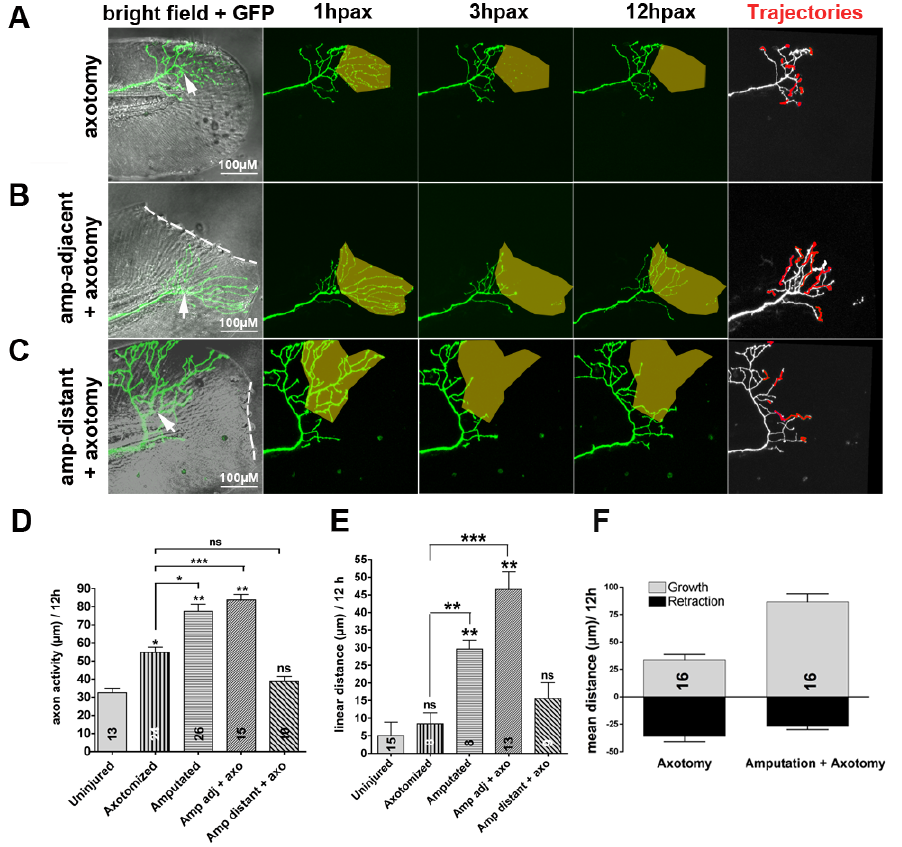
Figure 3. Signals from injured fins promoting axon regeneration function at short range. (A–C) Time-lapse sequences from 78–90 hpf. The rightmost panel shows axon tip trajectories (red) over the course of the time-lapse. (A) Axotomy (arrow) without amputation (see also Video S2). Axotomy increased axon activity, but axons were unable to reinnervate denervated territory (shaded area) (Figure S2). (B) The ability of an axotomized arbor (arrow) to reinnervate denervated territory (shaded area) was improved by fin amputation (dotted line) (see also Figure S2 and Video S4). (C) Axotomized arbors distant from the amputation plane did not regenerate (see also Video S5). (D, E) Comparison of axon activity (growth and retraction) (D) and linear growth distance (E) in uninjured arbors, after axotomy alone, after amputation alone, or after axotomy and amputation, both in close proximity (adj) or at a distance of greater than 50 m m. (F) Comparison of growth and retraction between axotomized axons, and axotomized axons in larvae whose fins were also amputated. Amputation in addition to axotomy promoted a shift from balanced growth and retraction toward growth. Sample size for each group is indicated by the number in the bar. Error bars represent the standard error of the mean. For statistical analyses, we performed one-way ANOVA and either Dunnett’s post-test to compare individual groups to uninjured controls (asterisks above bars indicate significance compared to control) or Bonferroni’s post-test to compare individual groups with each other (as indicated by brackets, p = ns . 0.05, * p , 0.05, ** p , 0.01, *** p , 0.001). hpax, hours post axotomy; amp,